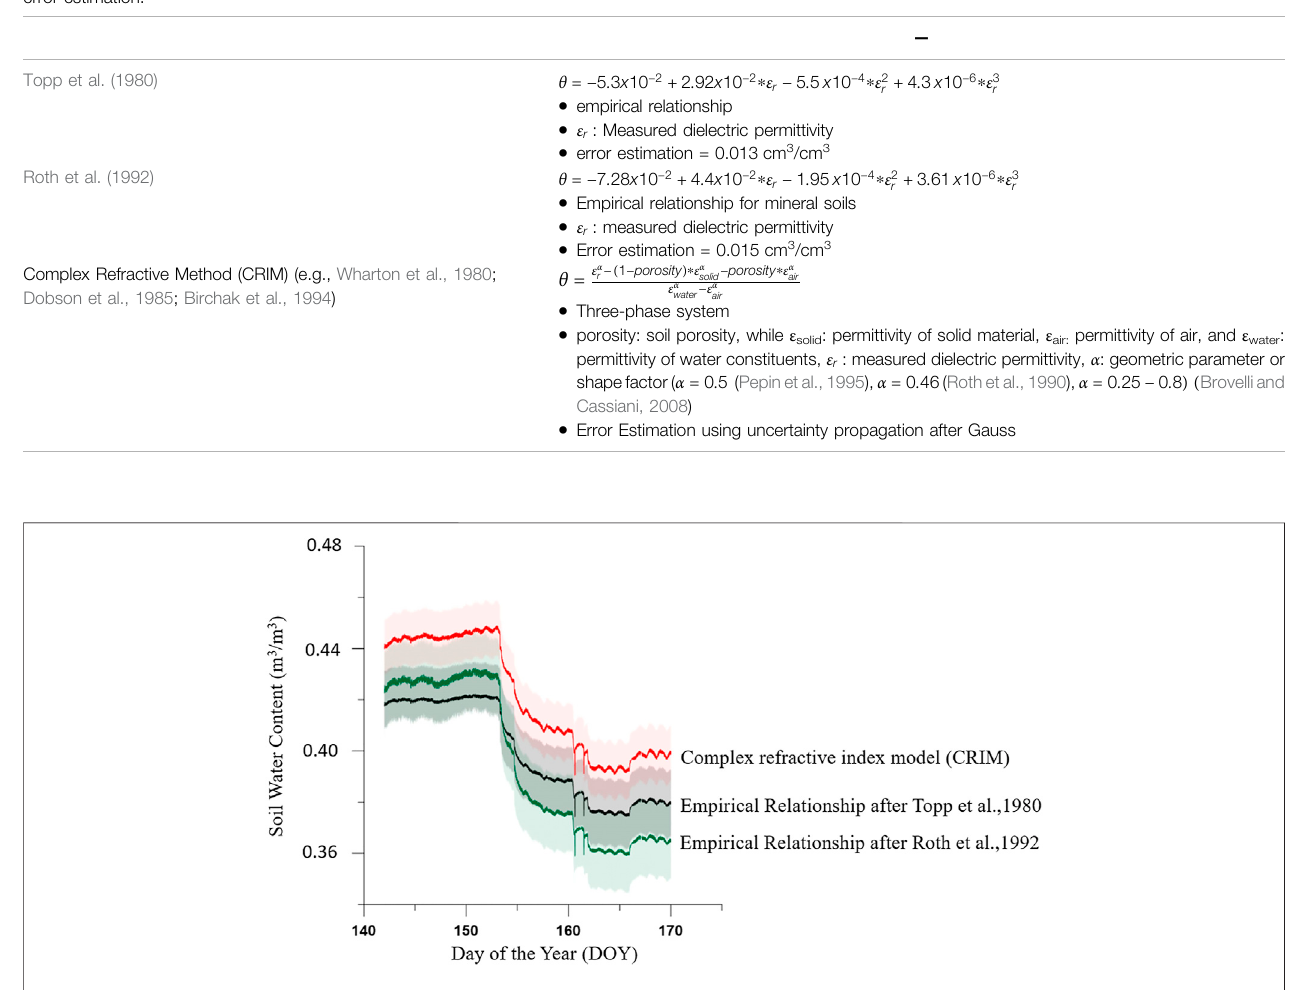
FIGURE 6 | Application of different PTFs on measured dielectric permittivity data. The panel shows derived soil water content in cm 3 /cm 3 and the related uncertaintyforthreedifferentPTFs.Panelshowsthechangingenvironmentalconditions.Startingatday153,therearedryingprocessesinthesubsurface.Thesoilwater contents derived with different PTF show synchronous course but